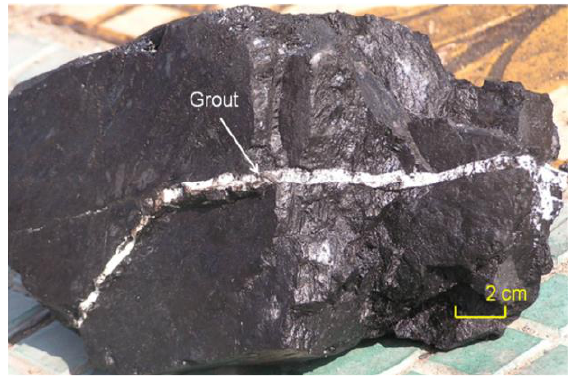
Figure 7. Photo of coal mass after consolidation.